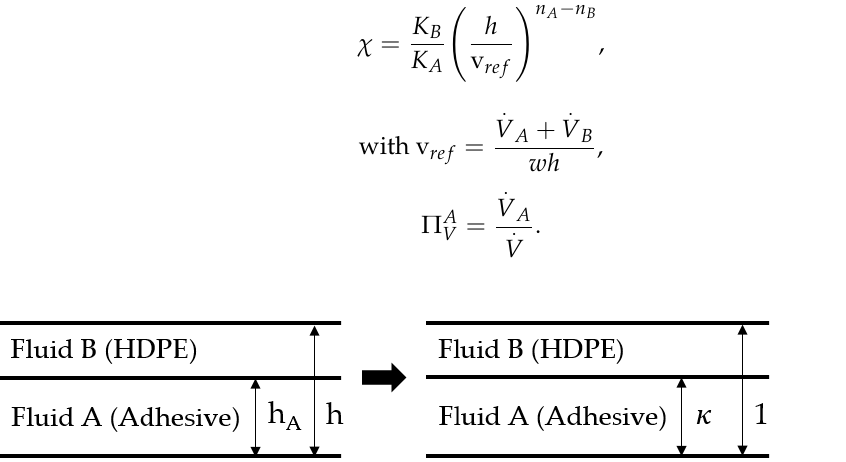
Figure 4. Schematic representation of the transformation of the flow channel from dimensional into dimensionless representation.